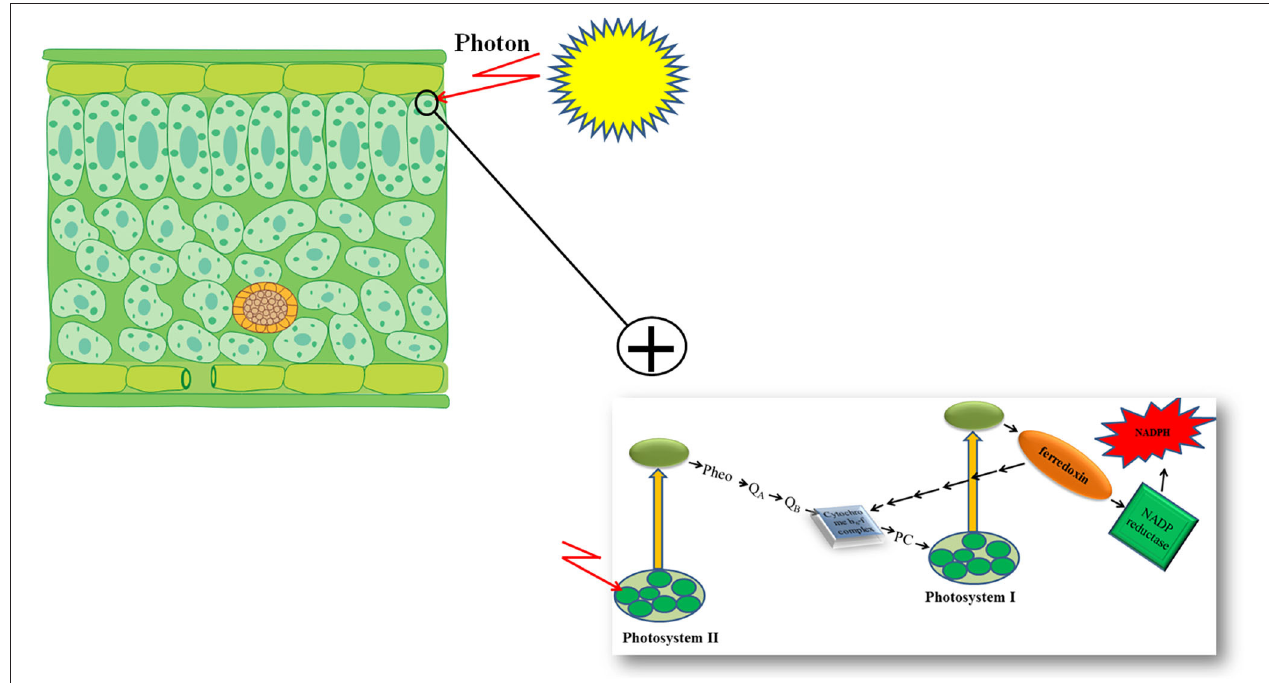
FIGURE 1 | Schematic presentation of photosynthetic electron transport chain of plants.